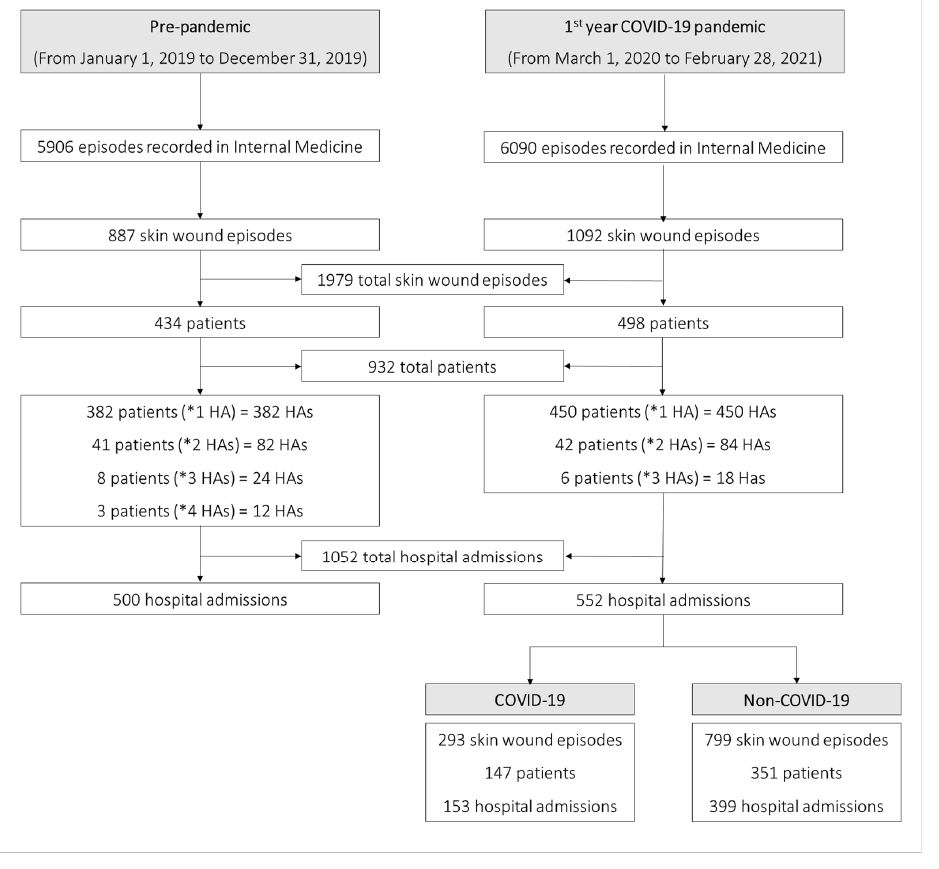
Figure 1. Flow chart of episode records. (* HA) refers to the number of hospital admissions. The percentage of skin wound episodes in the first year of COVID-19 pandemic was higher than pre-pandemic year, 17.9% (1092/6090) versus 15% (887/5906). During the 1st wave, the percentage of skin wound episodes was similar to pre-pandemic periods (14%), but the percentage of episodes increased significantly in the 2nd and 3rd waves (20.6% and 19.8%, respectively). Table 1 summarizes all the episode records collected and the measures of frequency